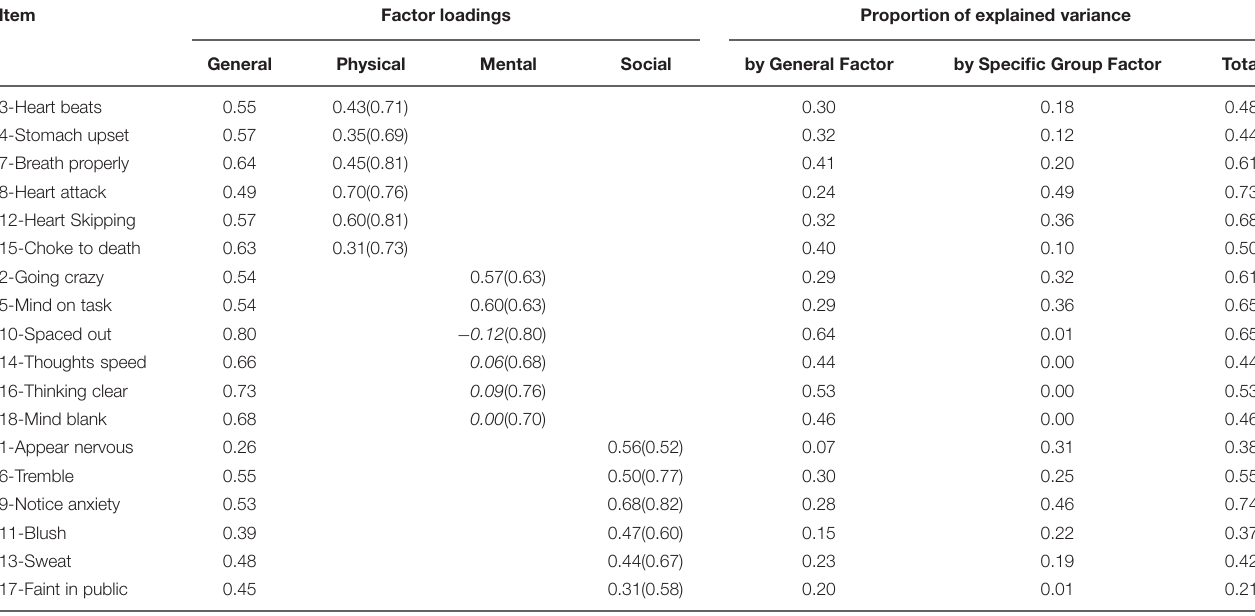
TABLE 3 | The estimated bifactor model ( N = 1507).